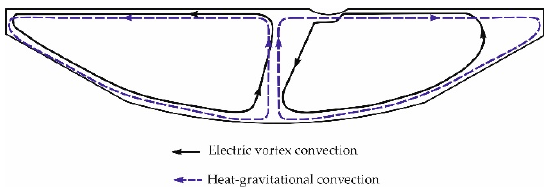
Figure 4. Simplified scheme showing interaction of the electric vortex and heat-gravitational convections.